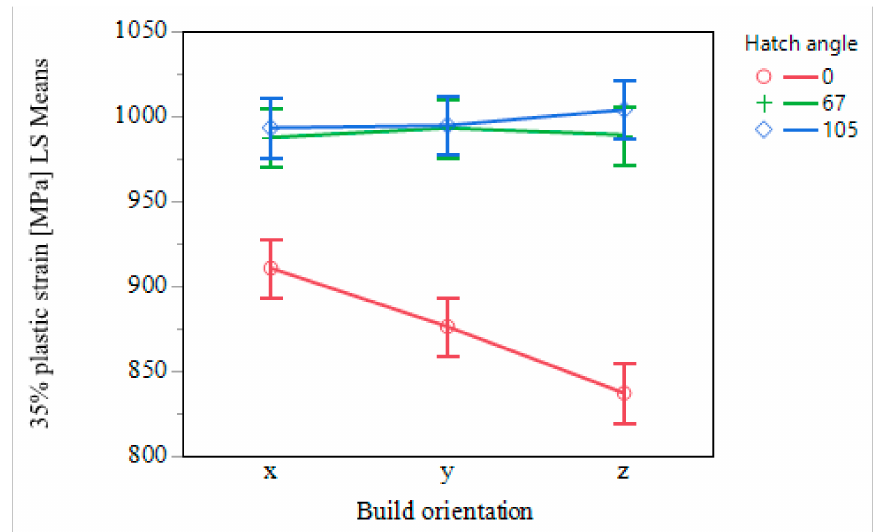
Figure 12. Least squares mean plot (flow stress at 35% plastic